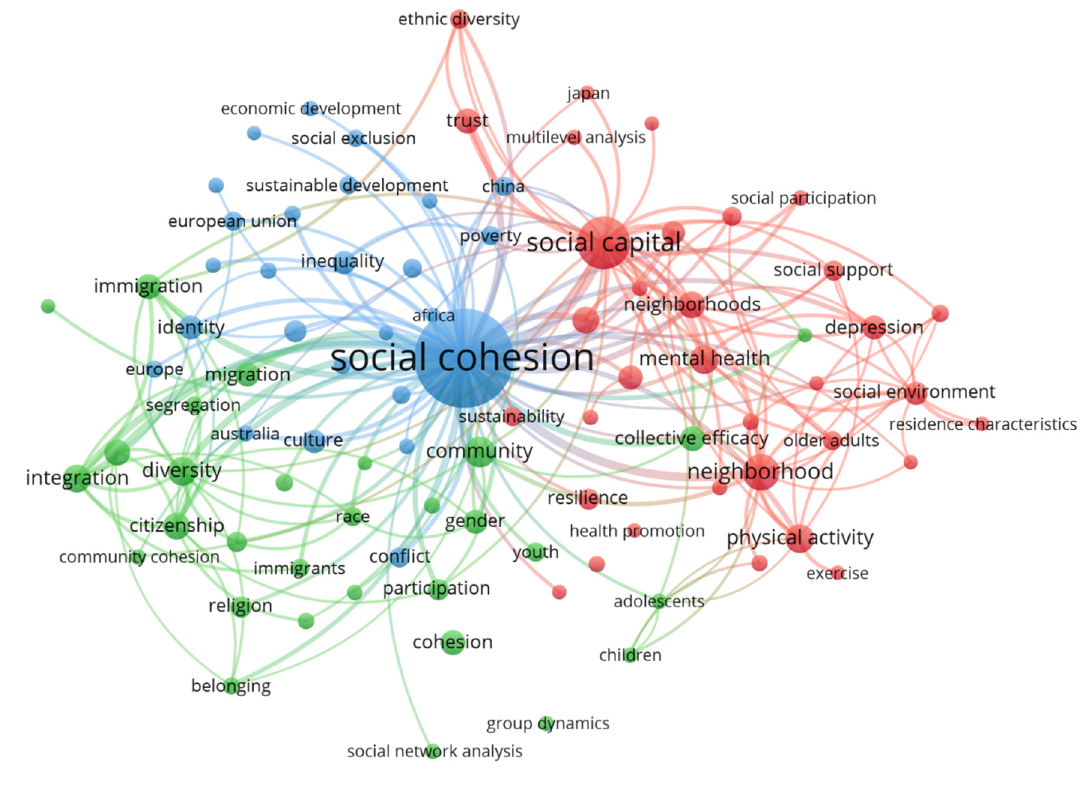
Figure 6. Author keyword co-occurrence network for “social cohesion.” The size of each node (circle) indicates the number of documents that have the corresponding term in their author keywords [38]. Lines represent co-occurrence between two terms and appear when terms co-occur at least four times.